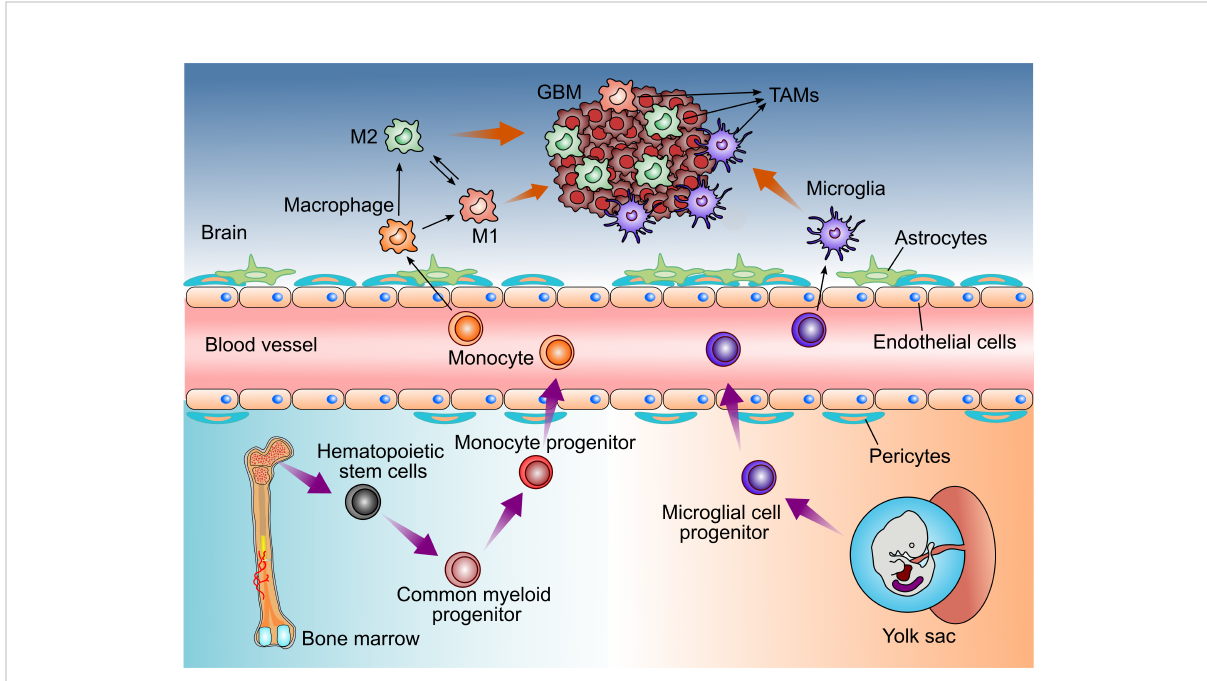
FIGURE 1 Distinct origins of Glioblastoma-associated Microglia and macrophages. Microglia derive from progenitors of the embryonic yolk sac, while peripheral macrophages are the monocytes deriving from the hematopoietic stem cells in bone marrow. Both cell populations enter the CNS and could be recruited by GBM cells, then referred to as tumor-associated microglia and macrophages